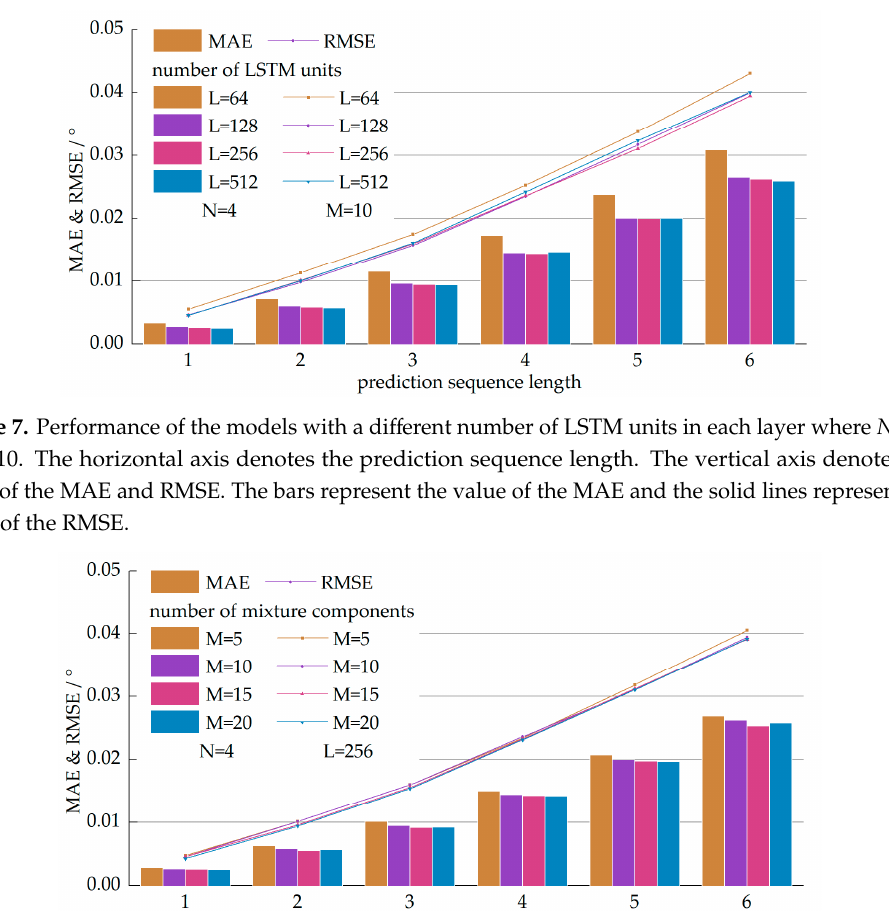
Table 1. The optimal parameter configuration of the BiRMDN model. BiRMDN: bidirectional recurrent mixture density network.